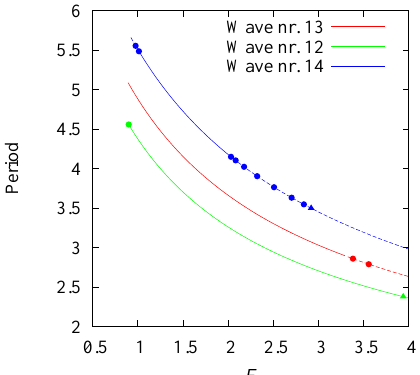
Figure 11. As Fig. 10, but for n = 60. For 1 . 01 < F < 2 . 03 three stable periodic orbits coexist. The Hopf bifurcations generating the waves with wave numbers 13, 12, and 14 occur at respectively F = 0 . 891, F = 0 . 894, and F = 0 . 923.